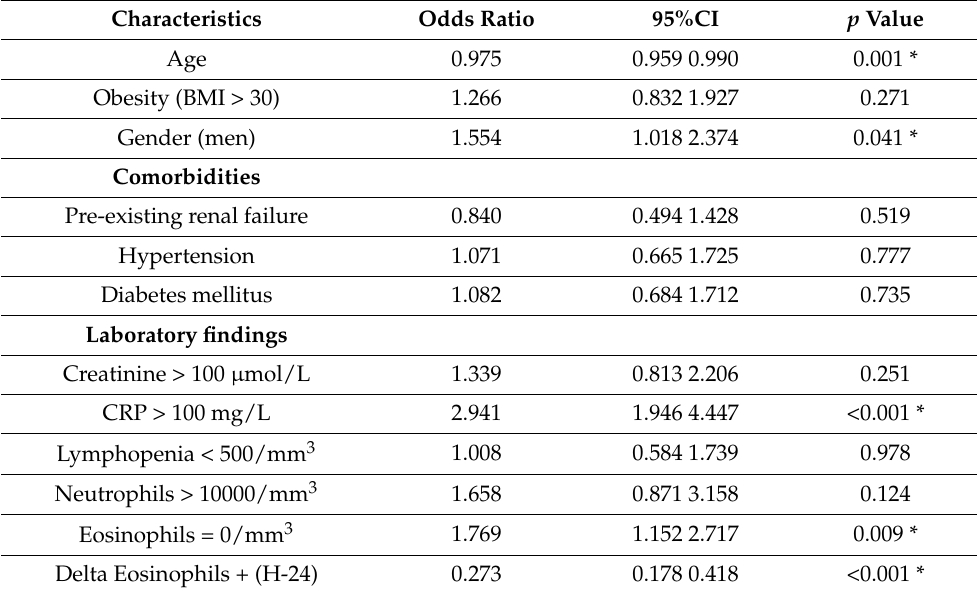
Figure 2. Receiver operating characteristics (ROC) curve for the ability of circulating eosinophils to predict severity of disease (ICU admission). Table 2. Multivariable analysis of patients with SARS-CoV-2 infection according to disease severity (ICU